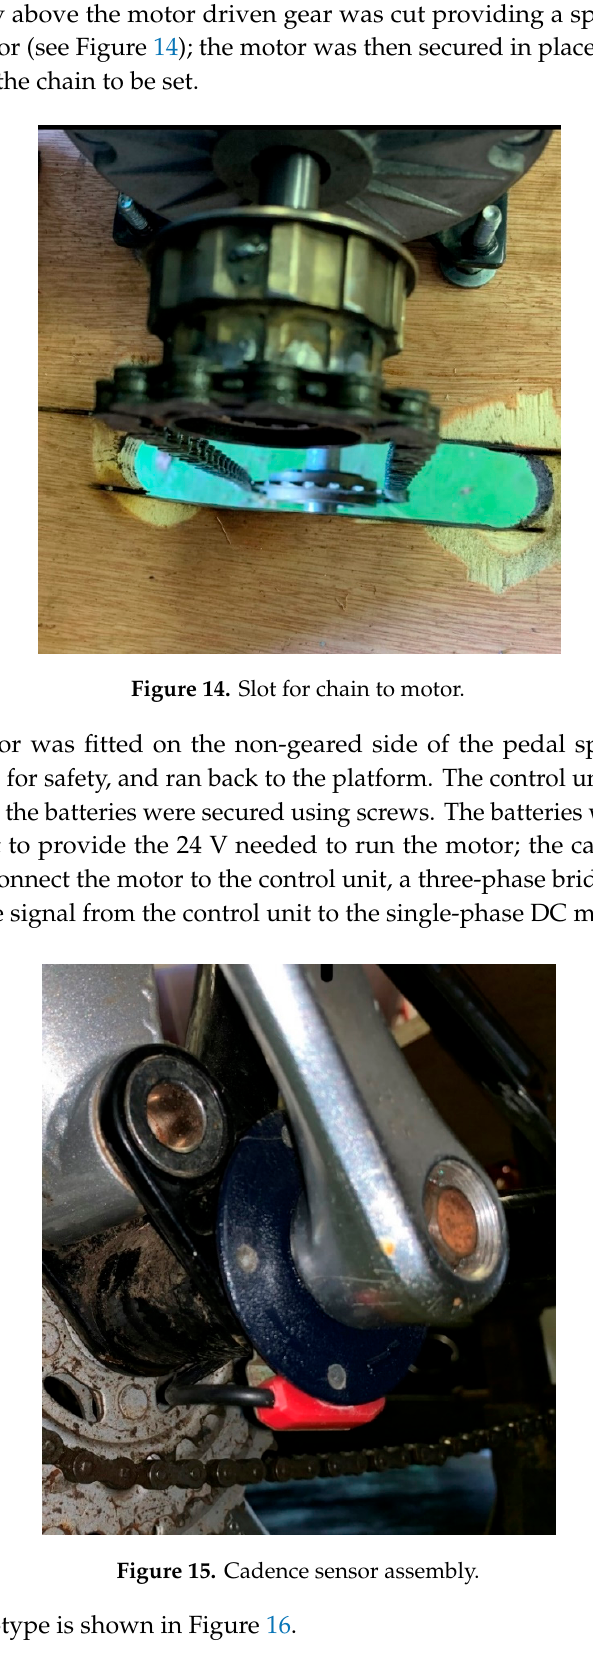
Figure 13. Platform housing electrical components.